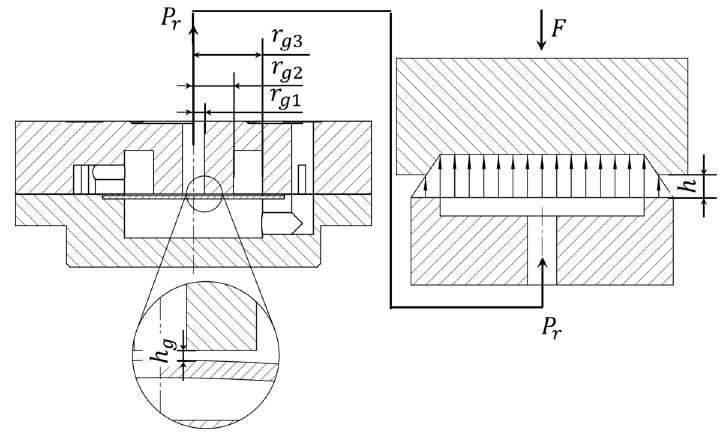
Figure 2. Single oil pad using a PSMR.